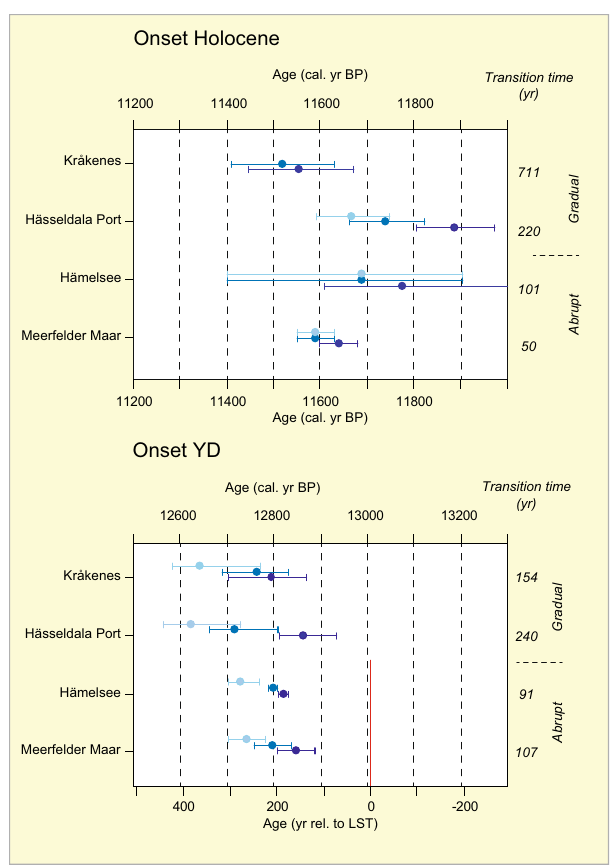
Fig. 4 Timing of the onset of the YD and the Holocene in high-resolution palynological sites. The onset of change for the YD and Holocene (dark blue), the date for the YD and Holocene onset sensu stricto (blue) and the end of the transitions (light blue) are given with 2-sigma uncertainty intervals. All dates are given in cal. yr BP except for the Meerfelder Maar ages for the onset of the YD, which are given relative to the LST, which is indicated by the solid red line. All records show a synchronous onset of the transition into the YD, with more abrupt transitions (shorter interval between YD early and YD eq ) visible for the German sites. The dates for the onset of the Holocene are more variable, re fl ecting larger uncertainties in the individual age/depth models. Note that the date for HOL eq at Kråkenes extends beyond the plotted time